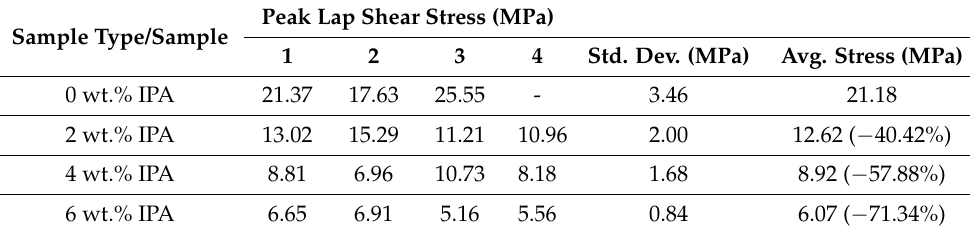
Table 1. Maximum lap shear stress of adhesive samples containing 0, 2, 4, and 6 wt.% IPA. Sample Type/Sample